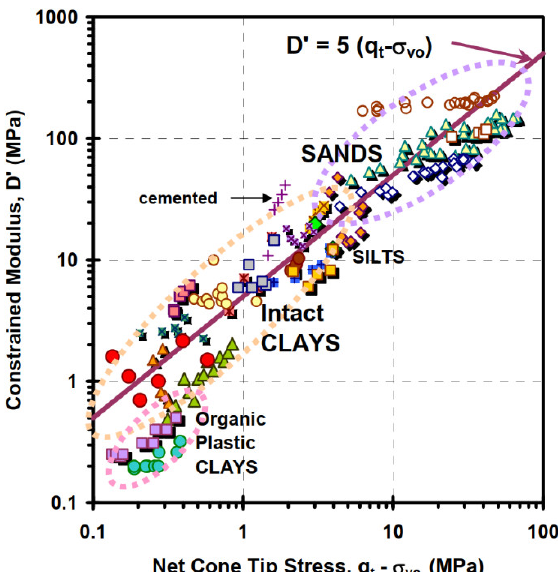
Figure 10. Correlation of soil compressibility modulus and cone resistance [11].